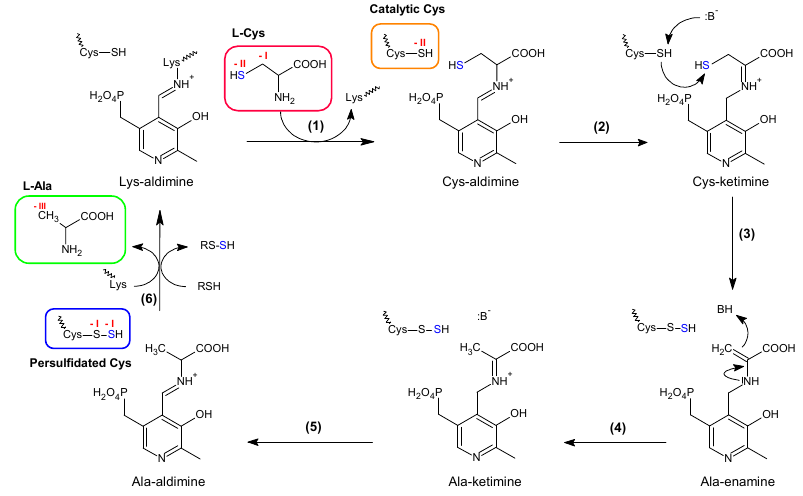
Figure 4. Mechanism of persulfide formation by cysteine desulfurases. The scheme presents the main intermediates in the catalytic cycle of cysteine desulfurases. The PLP cofactor is bound to the cysteine desulfurase backbone via the nitrogen of a lysine residue, in the form of a Lys-aldimine. The l -cysteine substrate exchanges with the lysine to form a Cys-aldimine ( 1 ), which is rearranged into a Cys-ketimine ( 2 ). A base (:B − ) deprotonates the thiol of the catalytic cysteine of the cysteine desulfurase and the resulting thiolate reacts with the thiol of the Cys-ketimine intermediate, which leads to formation of a persulfide on the catalytic cysteine ( 3 ). Concommitantly, adouble bond is created with the carbon of the former l -cysteine substrate in the form of an Ala-enamine ( 3 ). Upon protonation, the Ala-enamine is converted into Ala-ketimine ( 4 ) and then Ala-aldimine ( 5 ). The sulfane sulfur (blue) of the persulfide is transferred to a thiol acceptor and l -alanine is released by exchange with the internal lysine residue ( 6 and adjacent carbons) are indicated in red for the starting and final material. The reaction starts with